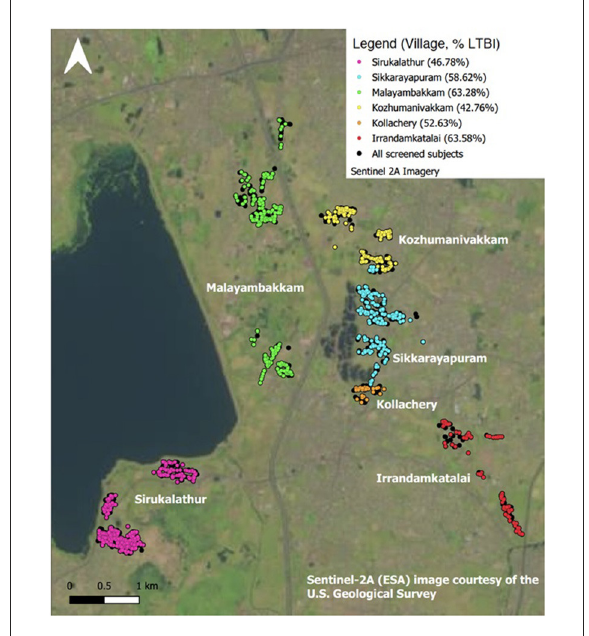
FIGURE1 Distribution of LTBI by study site. Map made in QGIS 3.10.11, study data displayed after processing in PostgreSQL and Pentaho. Contains information from OpenStreetMap and OpenStreetMap Foundation, which is made available under the Open Database License. OpenStreetMap data styled according to guidelines by https://github.com/charlesmillet.